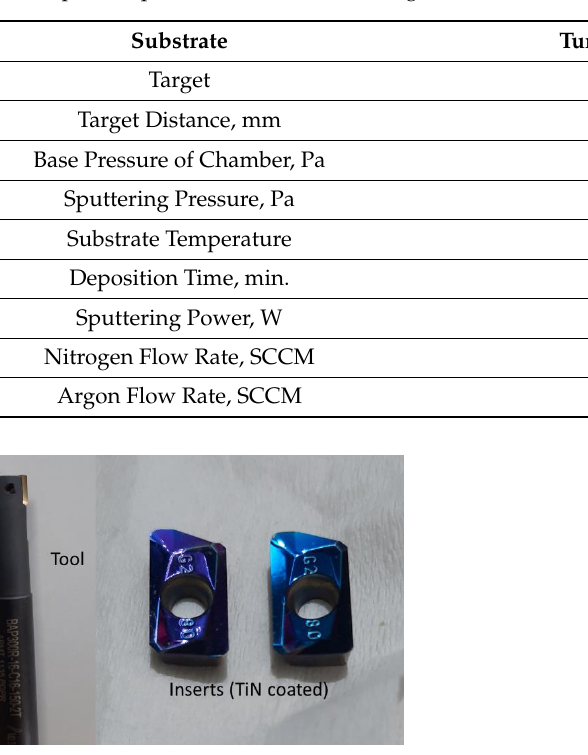
Table 4. The process parameters for PVD coating.